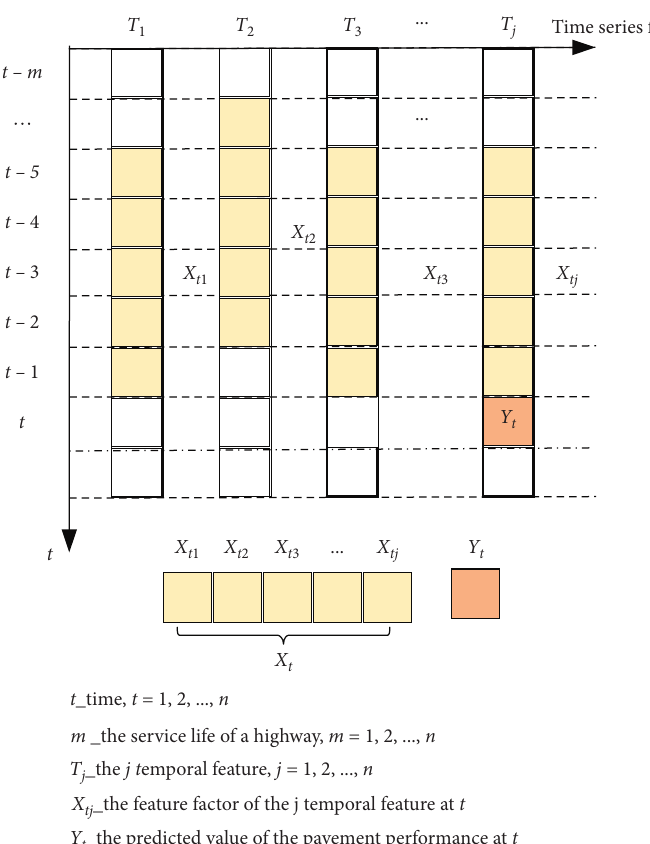
Figure 4: Time series feature extraction.